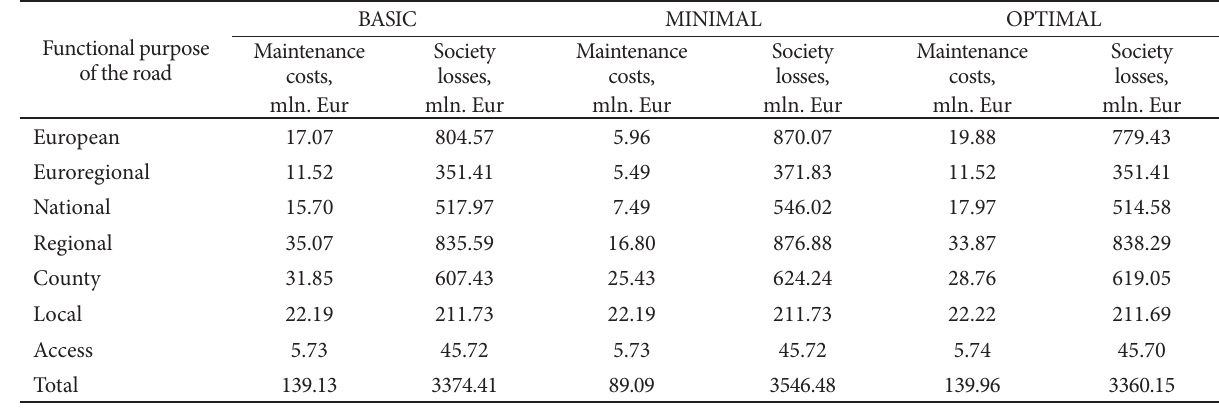
Table 3. The total expenses incurred by the society in the winter season in 2011–2014, in mln. Eur Functional purpose of the road